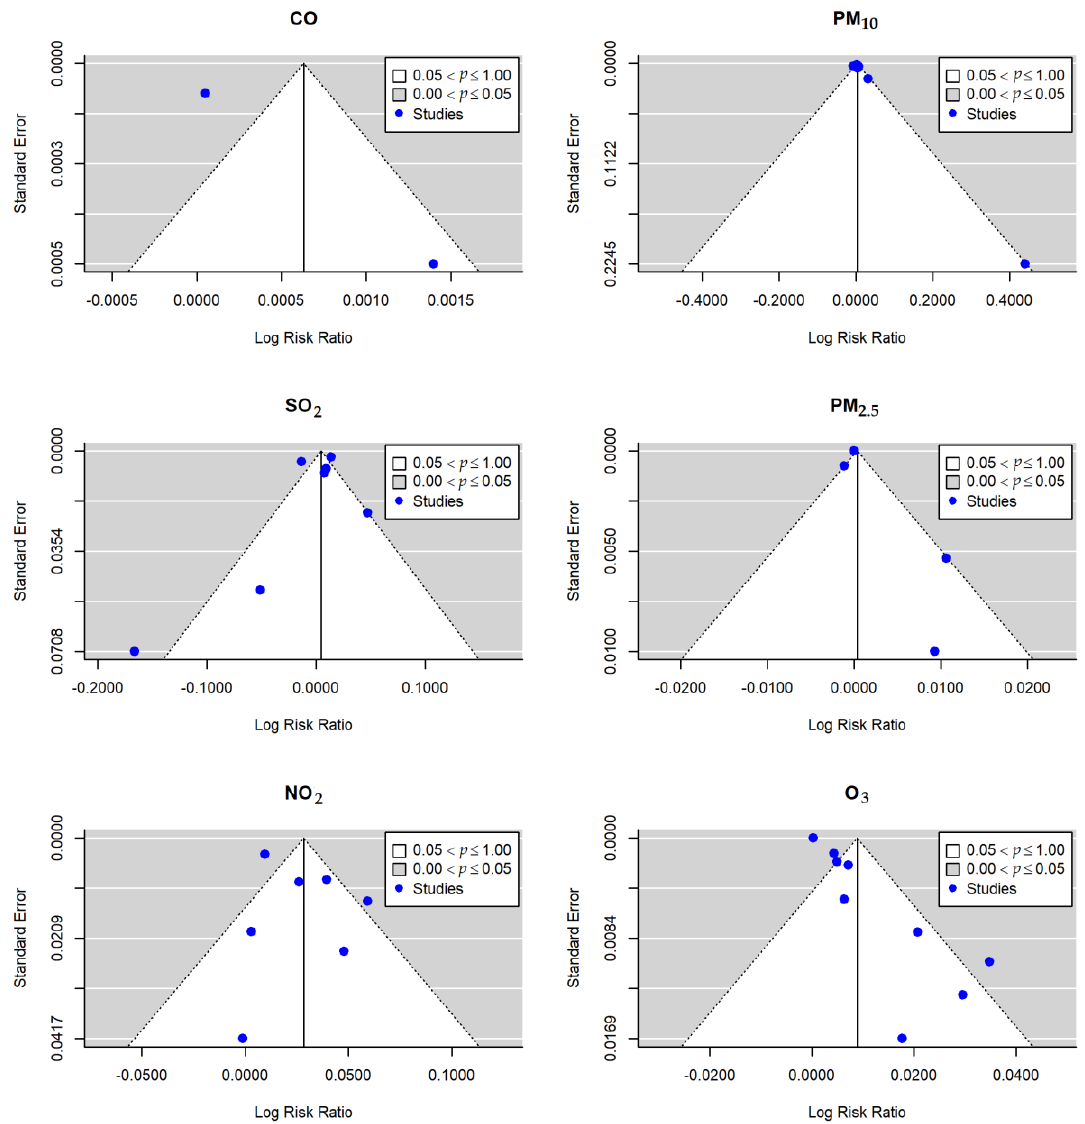
Figure 3. Funnel plot showing the risk of publication bias in the meta-analysis on the risk of conjunctivitis with per 10 μg/m 3 increase of air pollutants. Horizontal axis represents the log RR and vertical axis represents standard errors. Table 4. Begg’s test, Egger’s test, and trim-fill test on the effect of air pollutants on conjunctivitis.